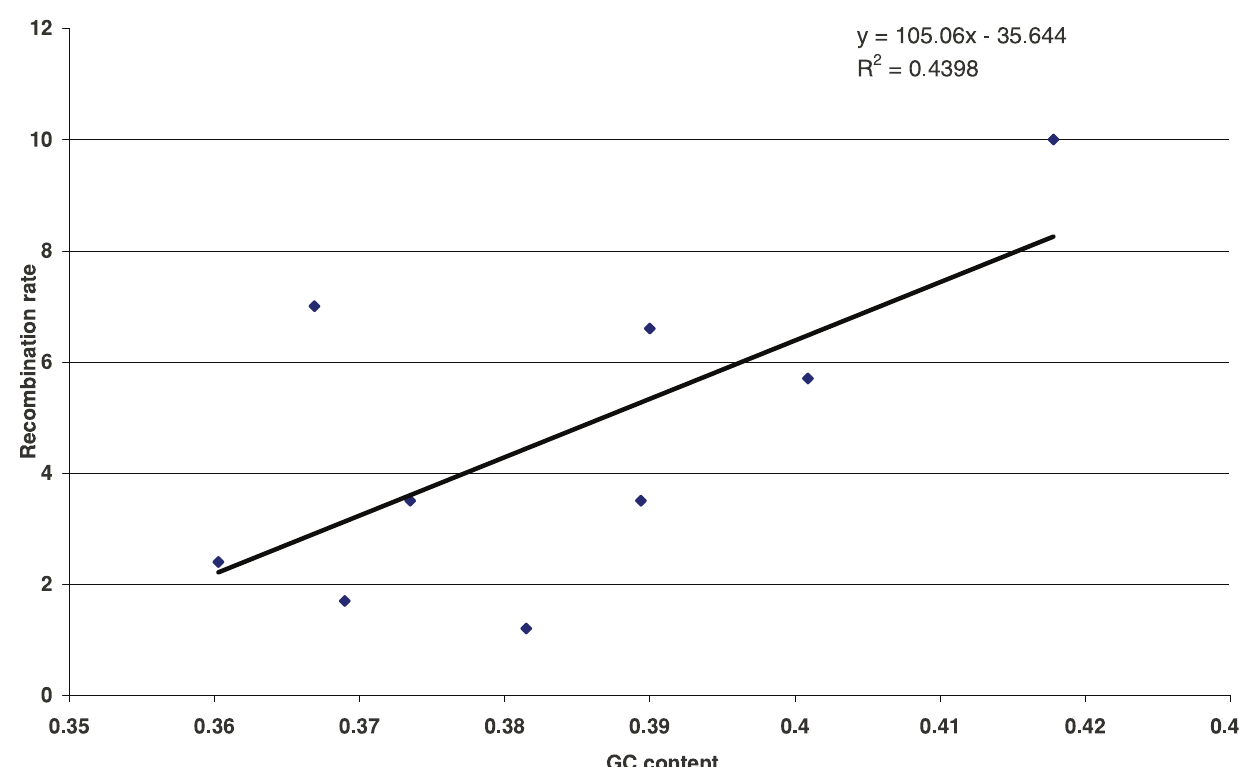
Figure 3. The G + C content of each of the nine flanking regions is plotted against their recombination rates. The regression line also is shown.